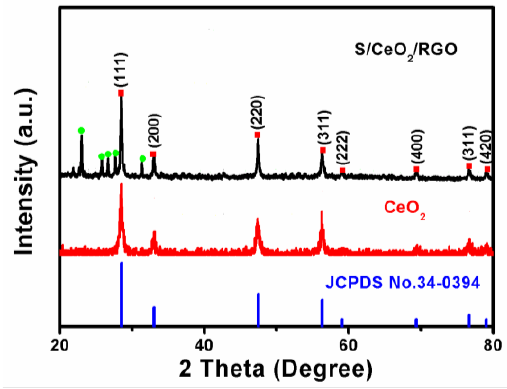
Figure 2. XRD patterns of CeO 2 and S/CeO 2 /RGO.